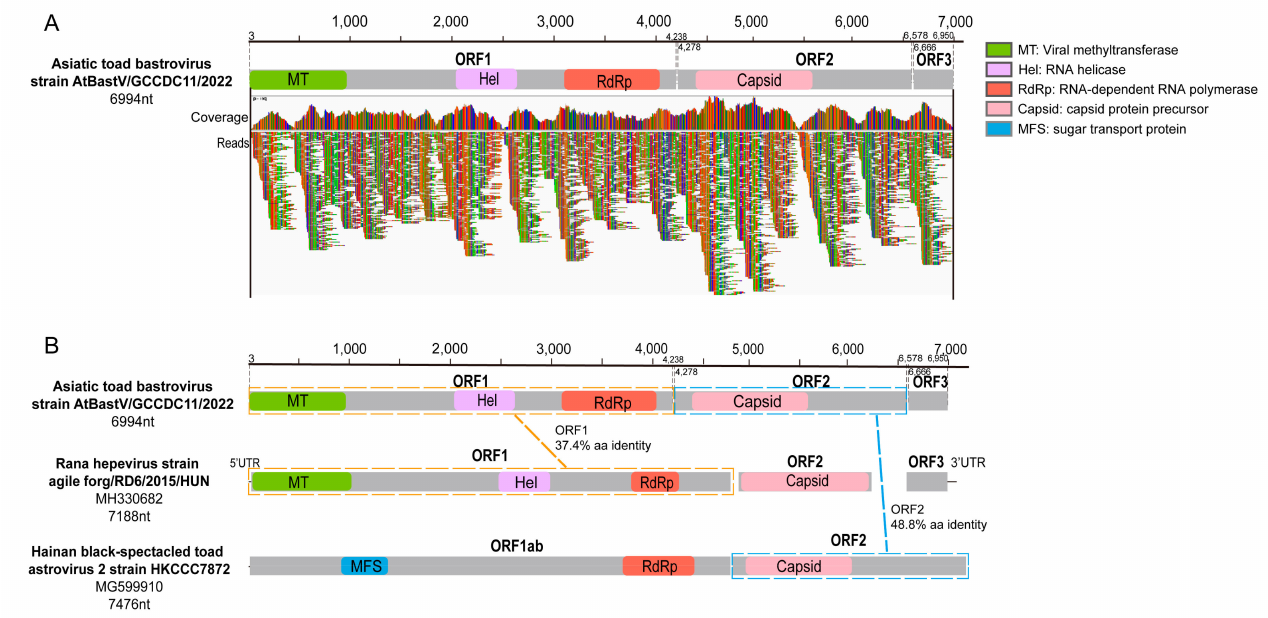
Figure 2. Schematic genome organization and comparisons of AtBastV/GCCDC11 with relative viruses. ( A ) AtBastV/GCCDC11 genomic organization consisting of three open reading frames (ORFs). Coverage and reads mapping to the genome are shown below the genome diagram. The genome map and each predicted ORF are drawn to scale. ORFs are shown in gray, and conservative functional domains are indicated in the legend on the right. ( B ) Comparisons of the genome structure of AtBastV/GCCDC11 with those of Rana hepevirus strain agile frog/RD6/2015/HUN (NC_040835) and Hainan black-spectacled toad astrovirus 2 (MG599910). The homology of ORF1 and ORF2 with other viruses is shown in the